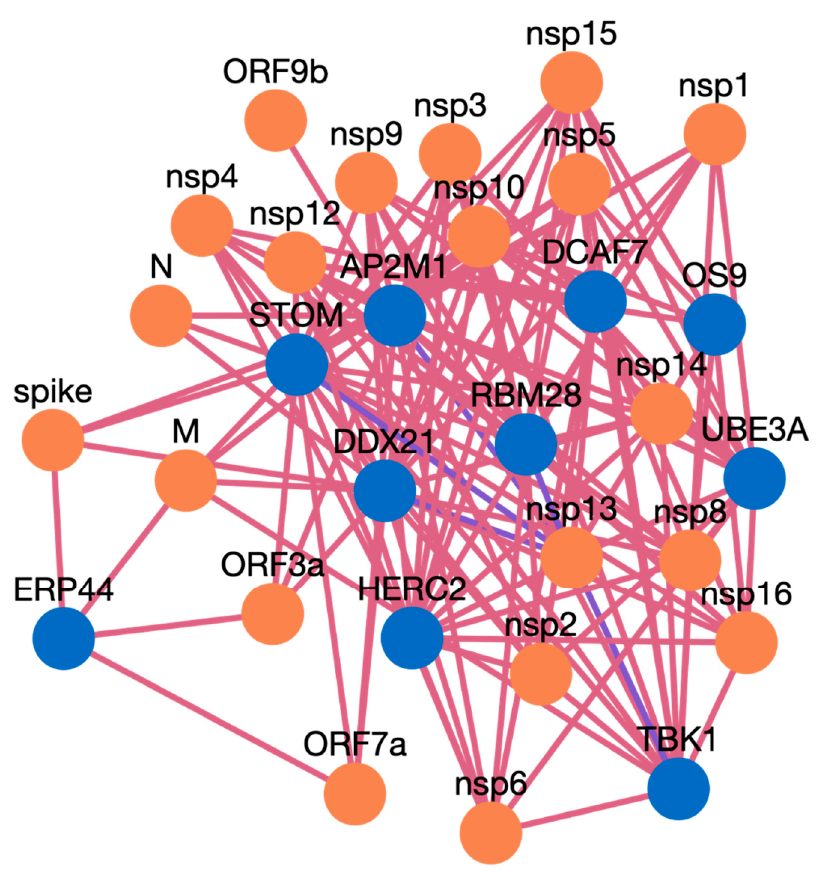
Figure 5. Network visualization of HPIs between ten genes and SARS-CoV.